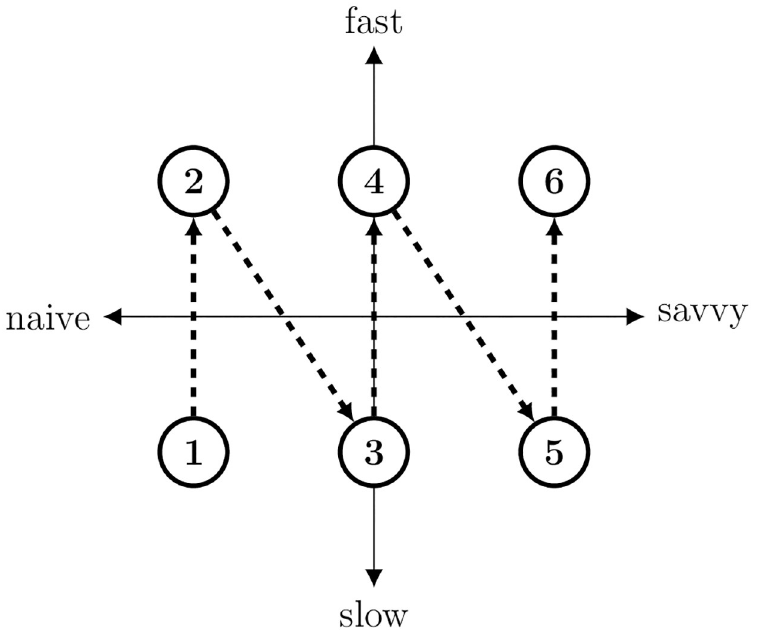
Fig 3. Graphical representation of the main hypothesis. Notes . Each dots represents a two-dimensional profile, from the lowest Profile 1 to the highest Profile 6. Probability of subject behaving consistently with backward induction increases with the direction of dashed